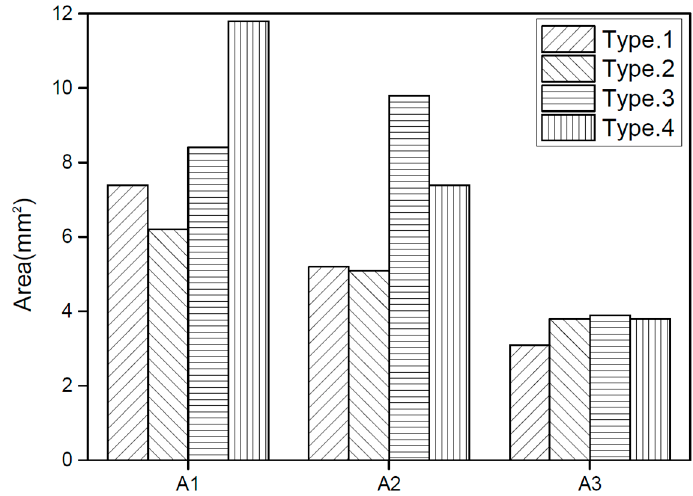
Figure 12. Measured area of each part on the weld bead.